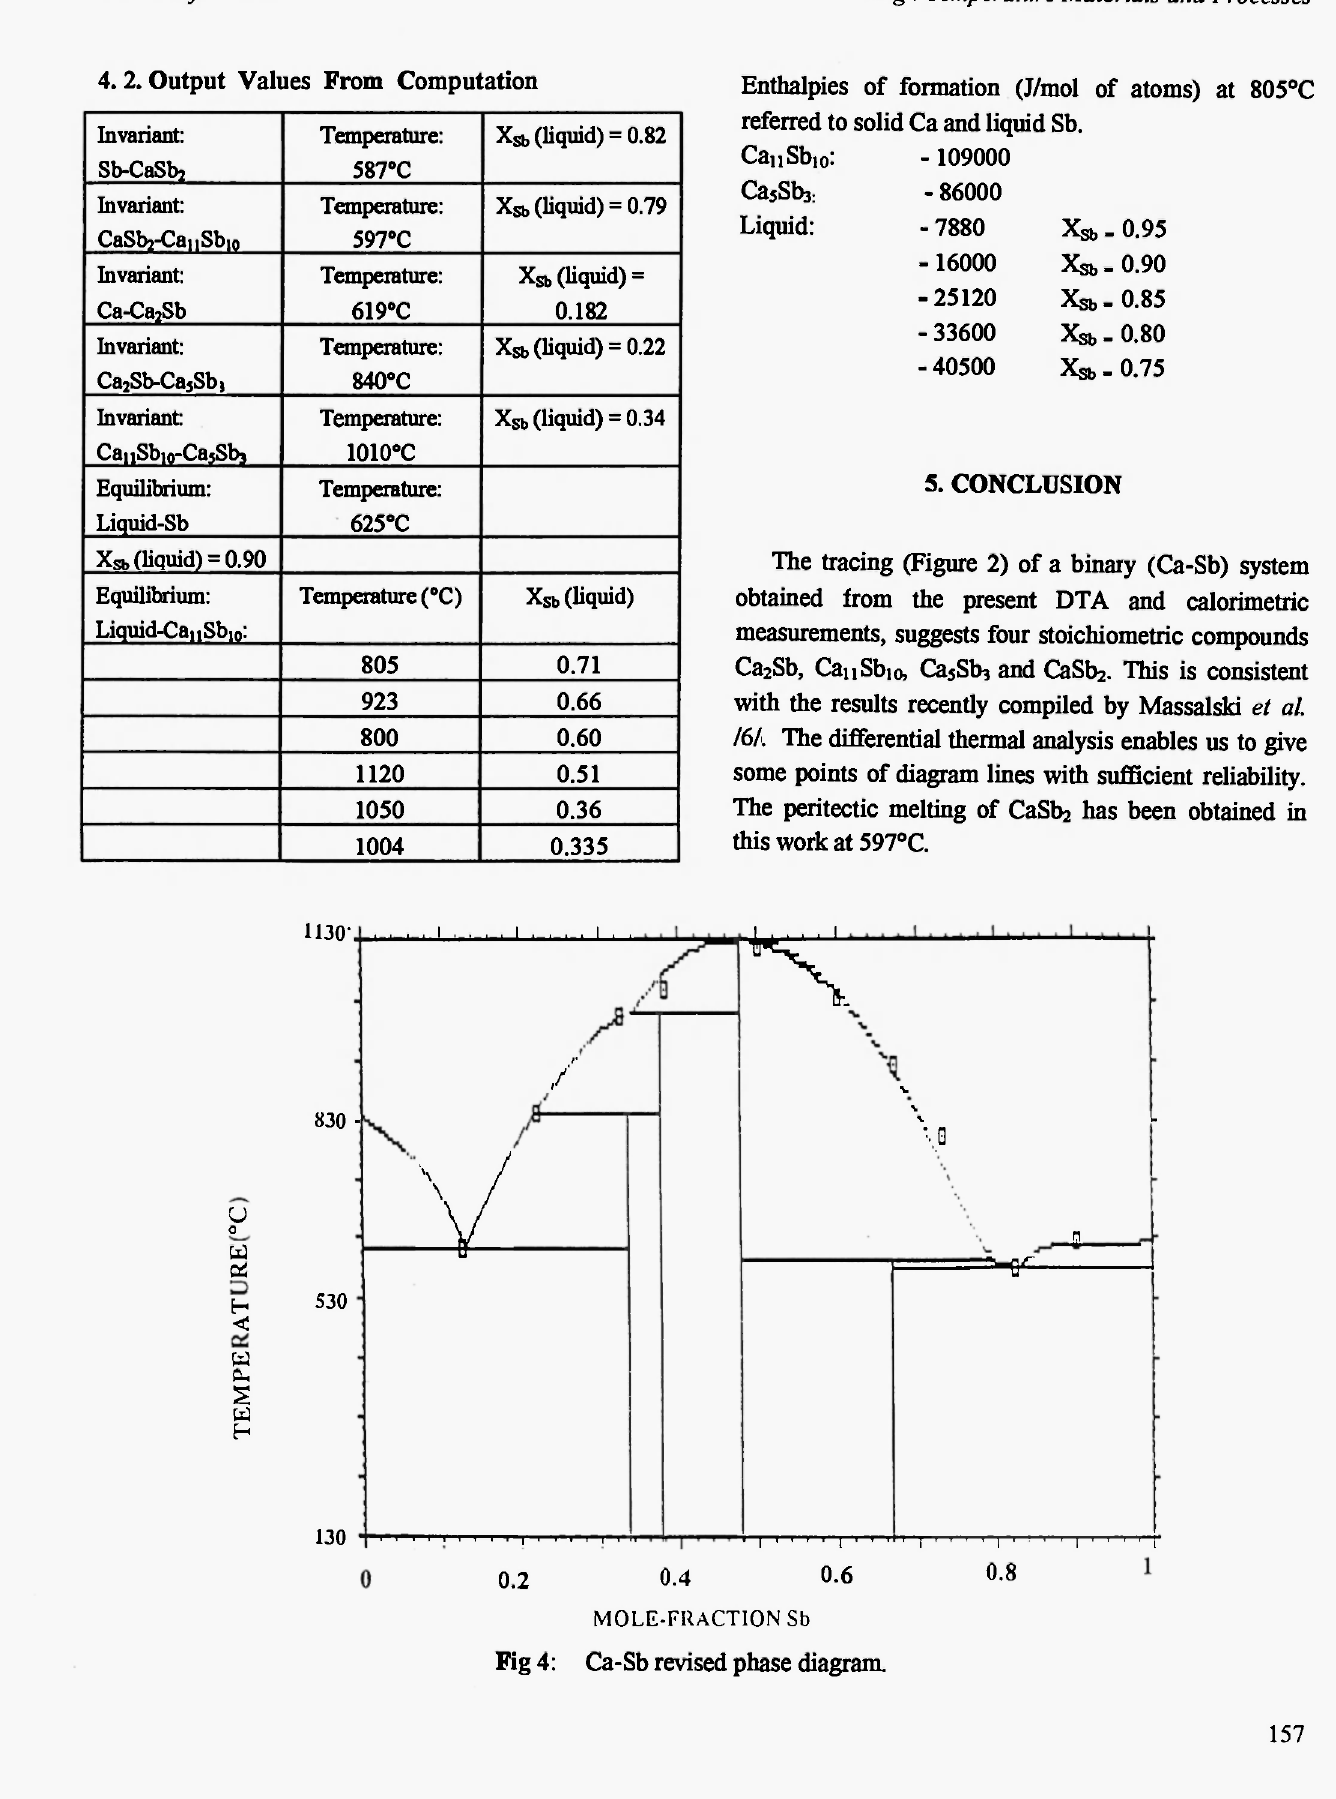
Fig 4: Ca-Sb revised phase